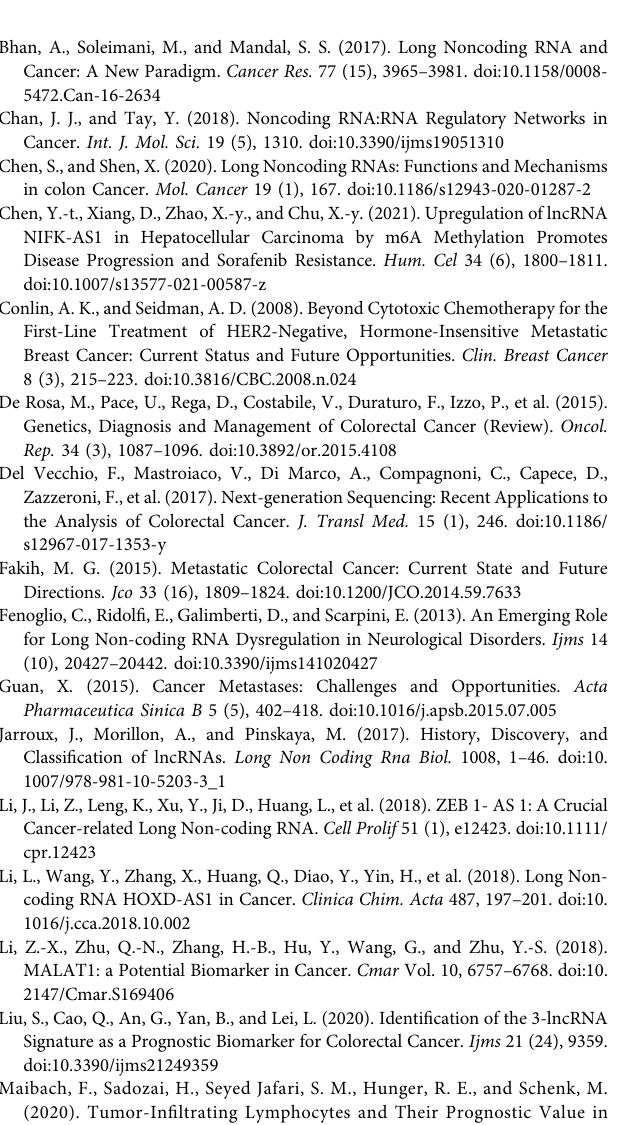
Supplementary Figure S1 | Kaplan – Meier survival curve analysis for the metastasis-related lncRNAs (A) CAPN10-AS1, (B) LINC00261, (C) LINC00925,